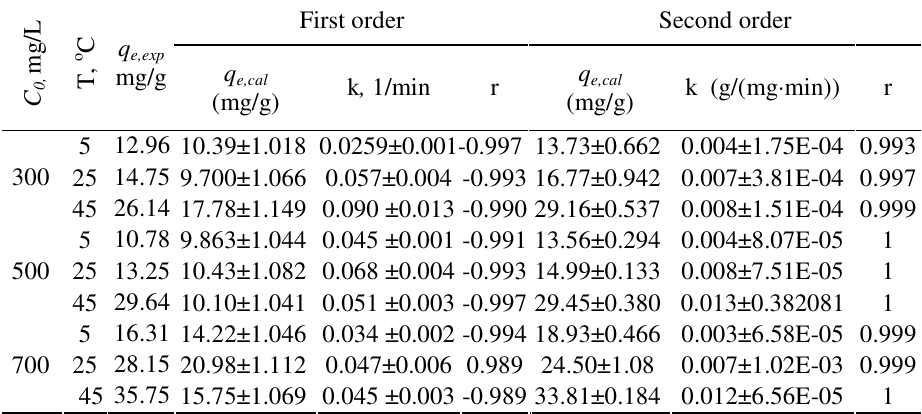
Table 7. Comparison of the adsorption kinetic models of PEG (20000) on EG First order Second order